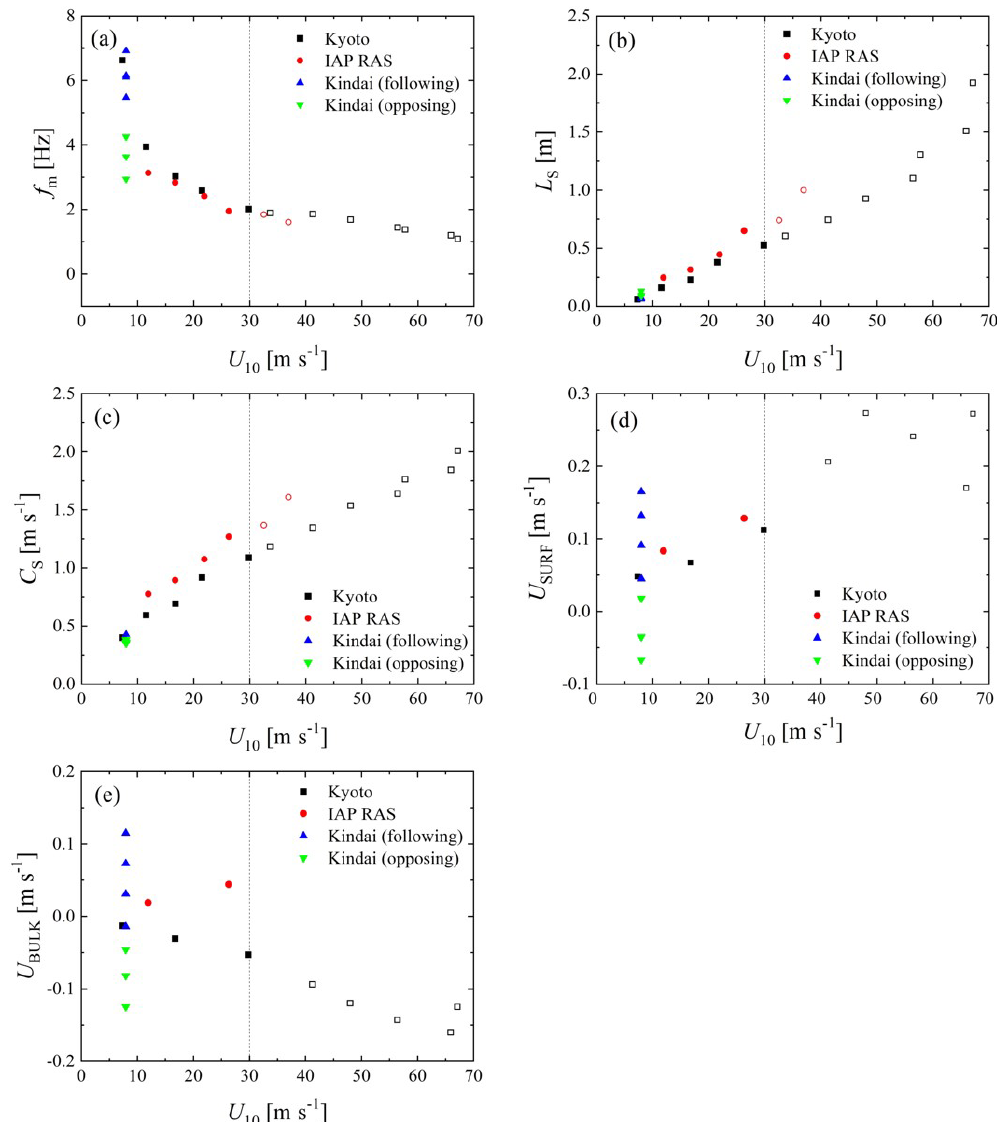
Figure 3. Relationships between U 10 and (a) significant frequency f m , (b) significant wavelength L S , (c) phase velocity C S , (d) surface velocity of water U SURF , and (e) bulk velocity of water U BULK . Open symbols show the high-wind-speed